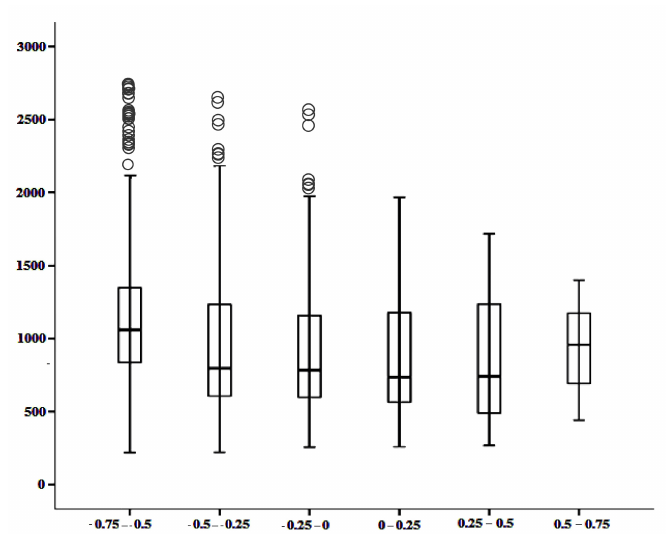
Figure 7. Boxplot of altitude in different sensitivity index (SI)